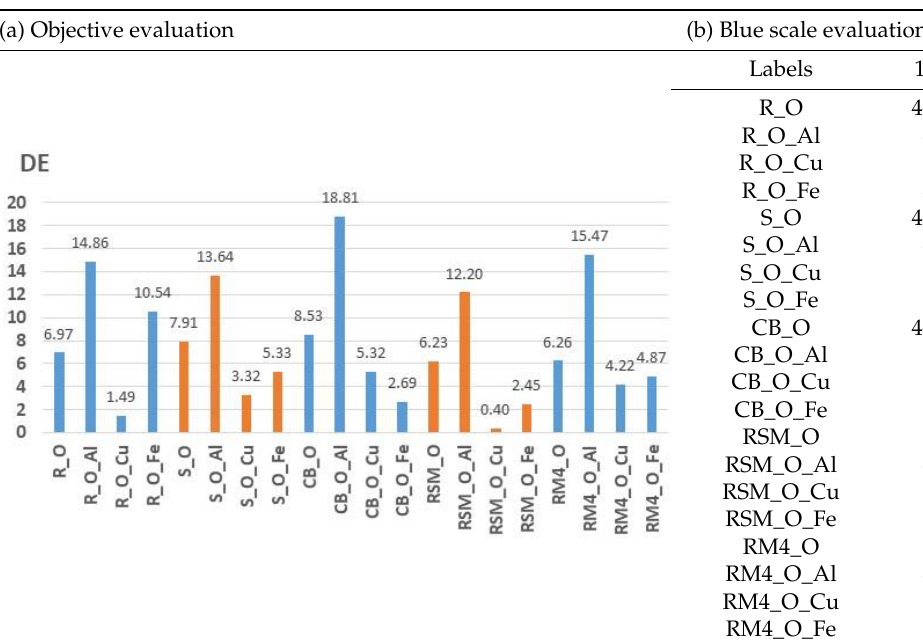
Table 9. Light fastness of cotton yarns dyed with onion peel.